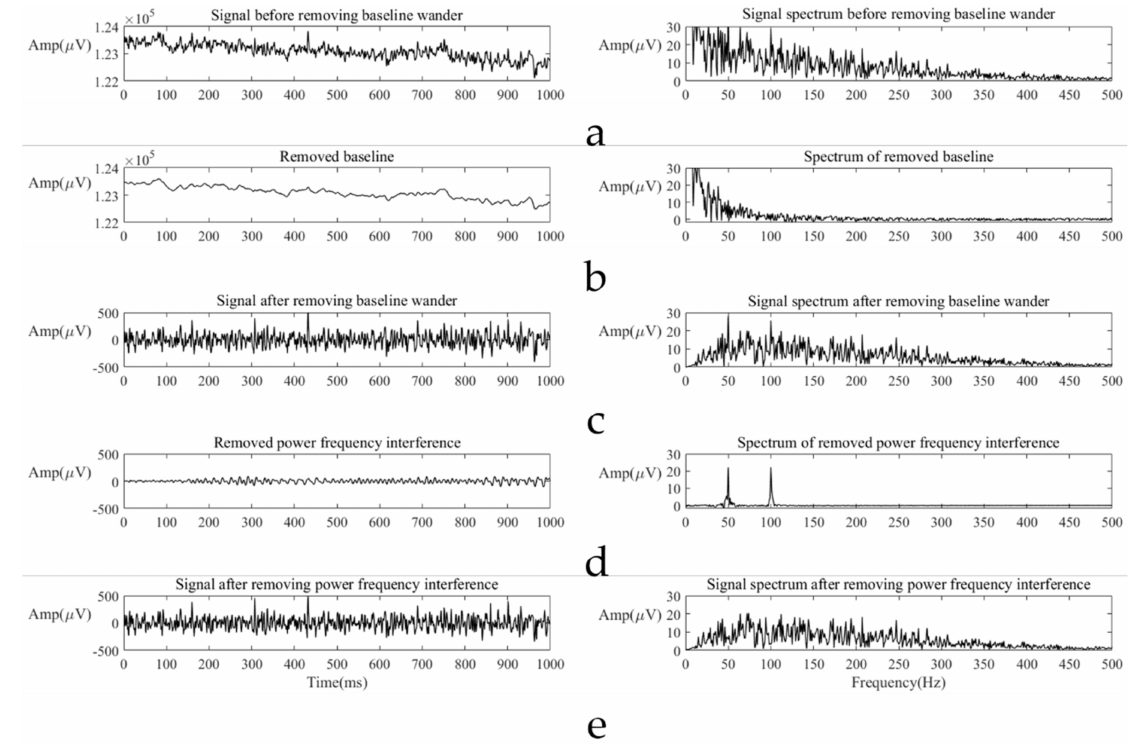
Figure 4. An example of removing baseline wandering and power frequency interference. Preprocessing result of a signal includes the signal before preprocessing ( a ), removed baseline ( b ), the signal after removing baseline ( c ), removed power frequency interference ( d ), and the signal after preprocessing ( e ). For each subgraph, the left graph is the time domain signal, and the right graph is the spectrum of the signal. In the spectrum of subgraph ( b , c ), the upper limit on the y axis was fixed 30 µ V, because the amplitude in this region is too large (more than 100 mV) and contains no information but baseline